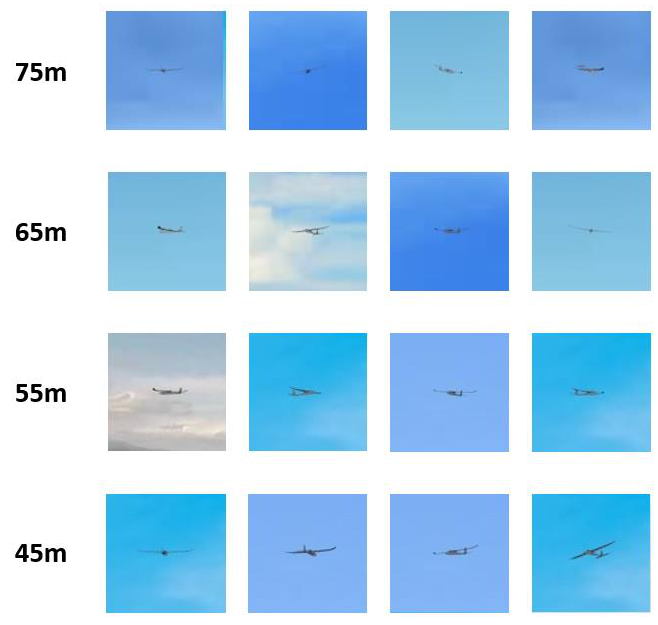
Figure 12. Examples of the cropped images with different distances and orientations for model training. Image Augmentation